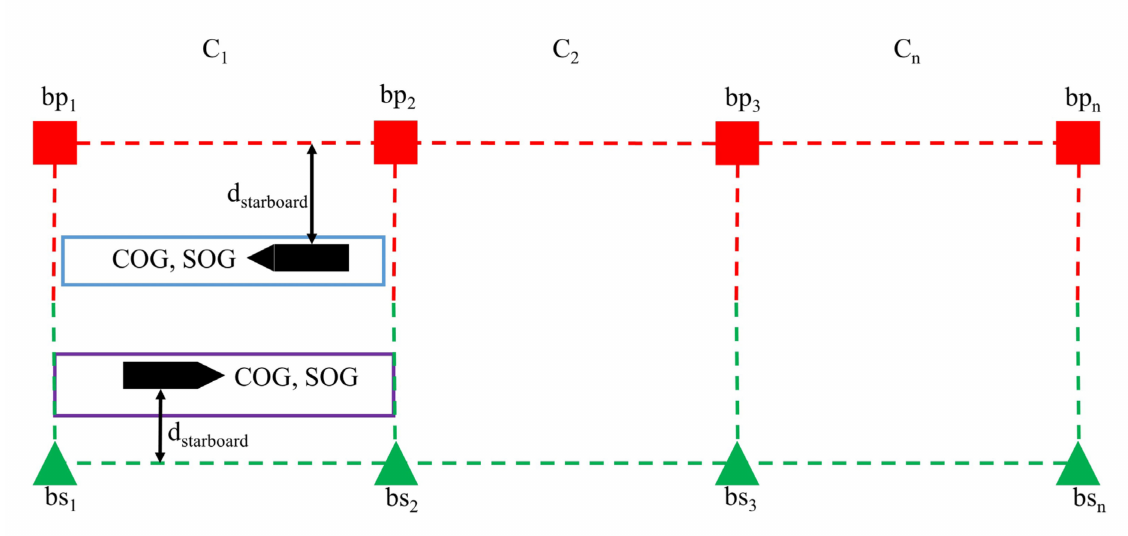
Figure 1. Schematic illustration of the proposed segmentation process in